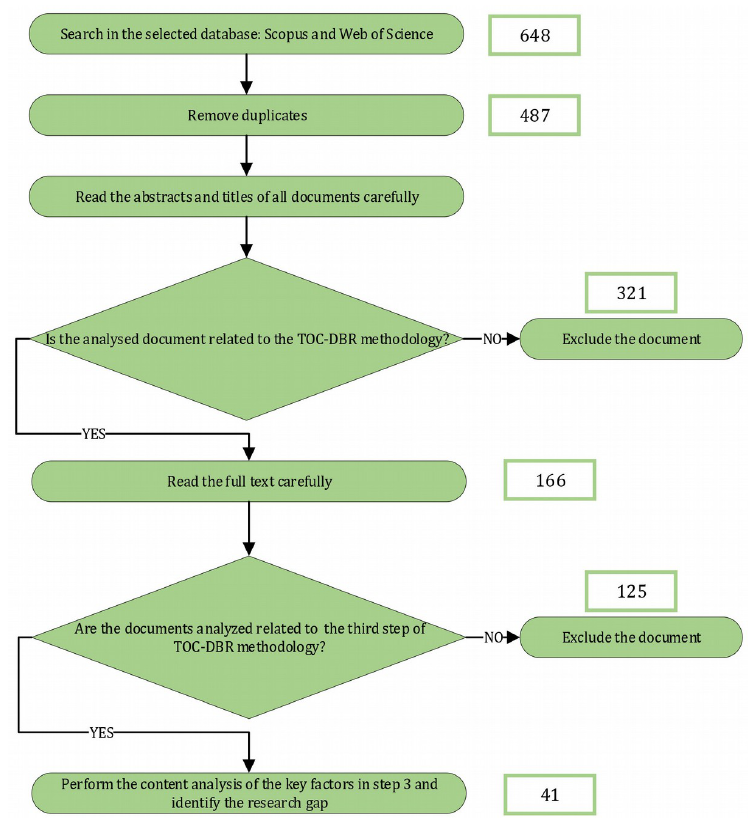
Figure 3. Literature review selection